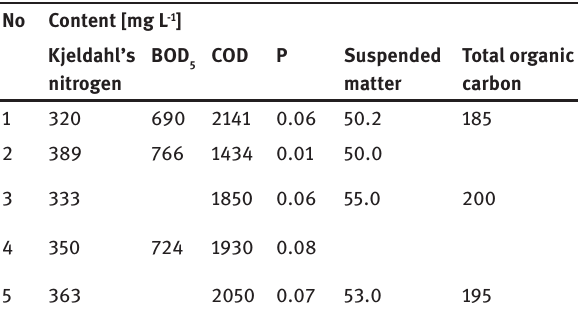
Table 6: Composition of industrial filtrate after pre-treatment.